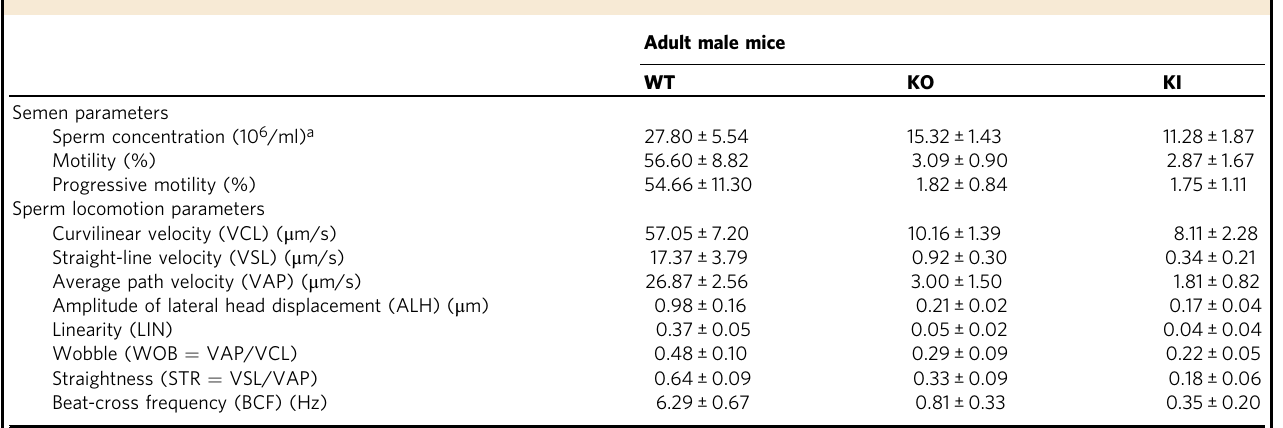
Table 1 Semen analysis using CASA in the mouse model of Cep128